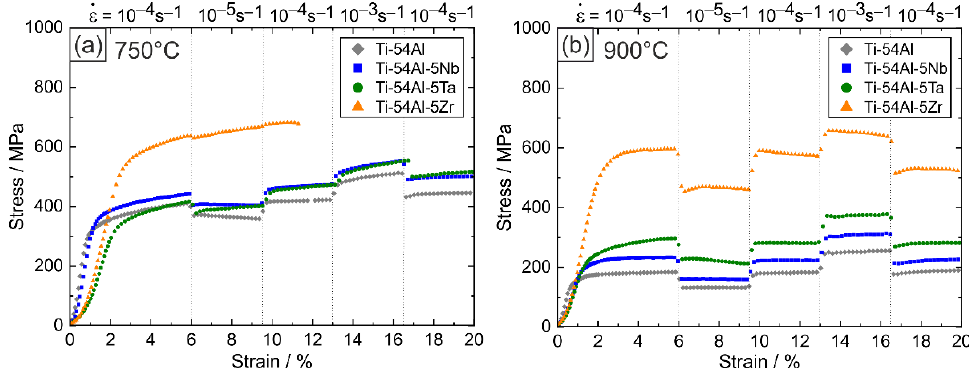
Figure 6. Compressional stress-strain curves of strain rate jump tests at ( a ) 750 °C and ( b ) 900 °C of the Ti-54Al-5X alloys and Ti-54Al.